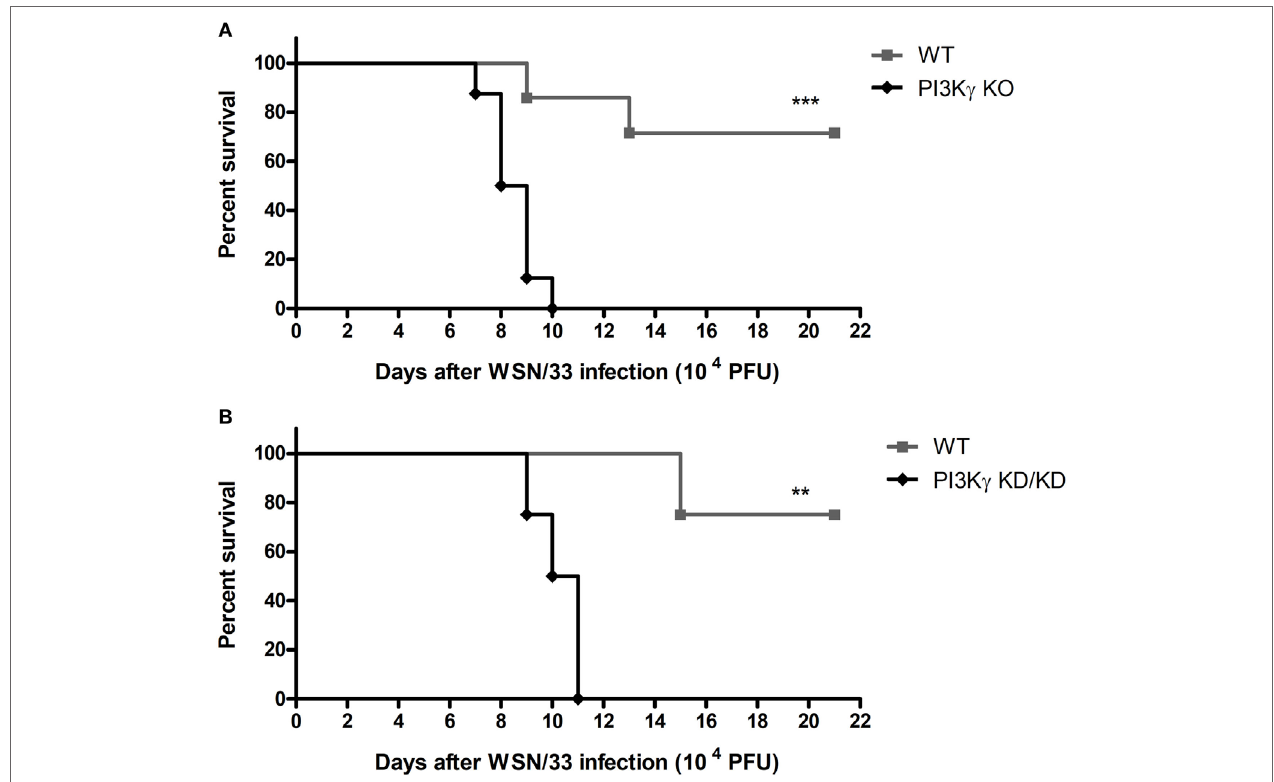
FigUre 1 | Lethality after influenza A virus infection in WT, phosphatidyl inositol 3 kinase-gamma (PI3K γ ) knockout (KO), and PI3K γ KD/KD mice. (a) Lethality of WT and PI3K γ KO mice intranasally infected with 10 4 plaque-forming units (PFU) of WSN; result is representative of two independent experiments with seven to eight mice per group (Log-rank test; *** p < 0.001). (B) Lethality of WT and PI3K γ KD/KD mice intranasally infected with 10 4 PFU of WSN; result is representative of two independent experiments with four to eight mice per group (Log-rank test; ** p <